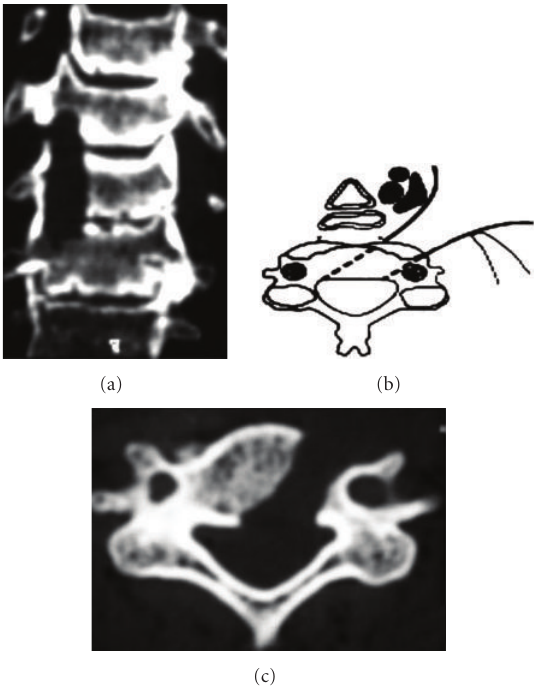
Figure 5: Postoperative (a) coronal and (c) axial CT scan show- ing wide spinal canal decompression after 1 level MOC; (b)— schematic